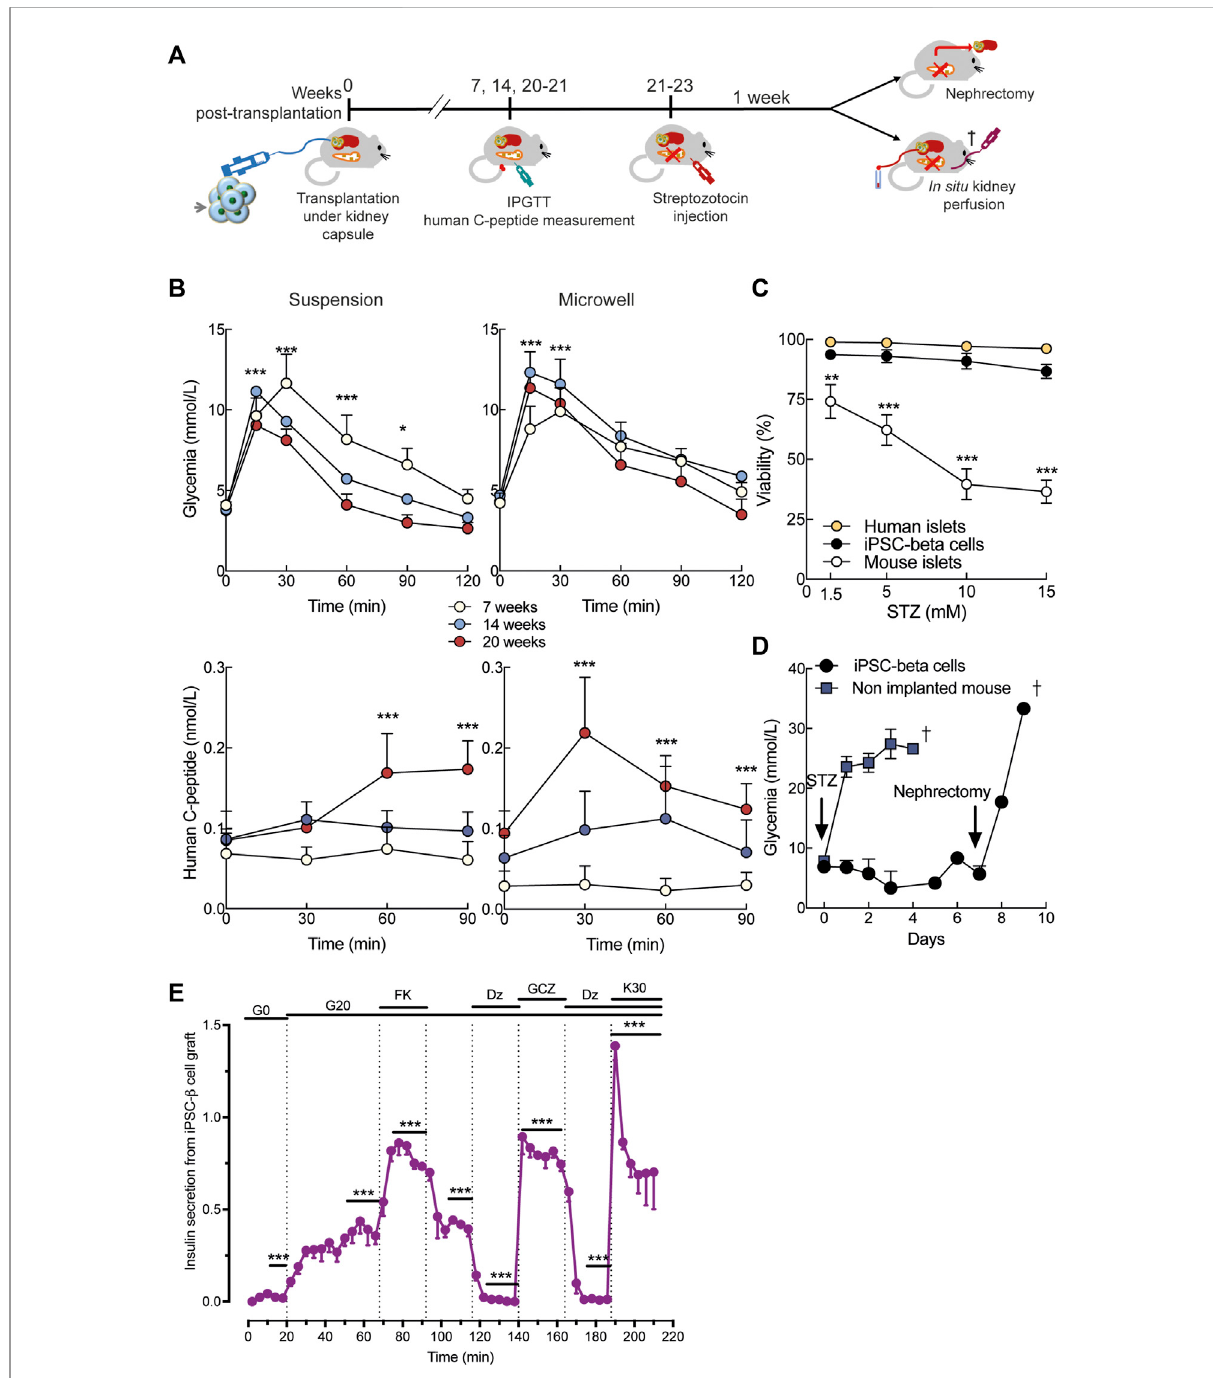
FIGURE 4 In vivo function of human iPSC-derived beta cells. (A) , Stage 7 microwell or suspension aggregates were transplanted under the kidney capsule of NOD-SCID mice. Intraperitoneal glucose tolerance test (IPGTT) was done at week 7, 14 and 20. At 21 – 22 weeks, mice were injected with streptozotocin (STZ) to selectively ablate mouse beta cells. Glycemia was recorded for 1 week before nephrectomy or in situ kidney perfusion. (B) , Mouse glycemia (top panels) and human plasma C-peptide (bottom panels) during IPGTT in suspension (left panels) and microwell (right panels). (C) ,Dose-responseofstreptozotocintoxicityinhumanislets(n=3),humaniPSC-derivedbetacells(n=5)andmouseislets(n=5)after24-h exposuretothedrug.Mixed-effectsanalysisfollowedbyBonferroni ’ scorrectionformultiplecomparisons,** p < 0.01,*** p < 0.005. (D) ,Twenty-one weeks after transplantation, a single dose of streptozotocin (200 mg/kg) was administered intraperitoneally. Non-implanted mice rapidly develop diabetes(blue,n=5).Micetransplantedwithstage7aggregatesremainnormoglycemicuntilgraftremovalbynephrectomy(black,n=5). (E) ,Kidney perifusion was performed 22 weeks after transplantation in two mice STZ-injected and one mouse non-STZ-injected. The grafted kidney was